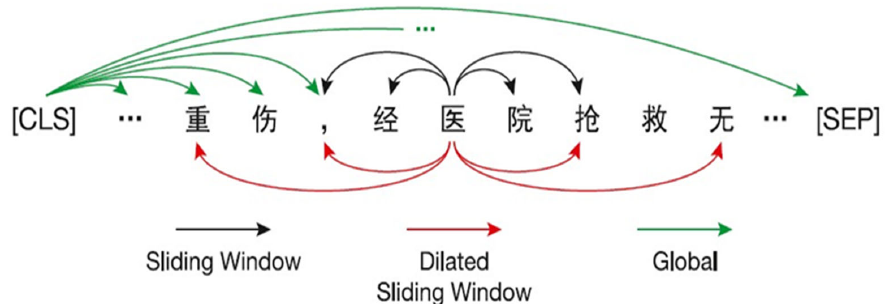
Figure 3. The combination of the three attention mechanisms in Lawformer. Note: The meaning of Chinese characters in the figure is “seriously injured by the hospital”.